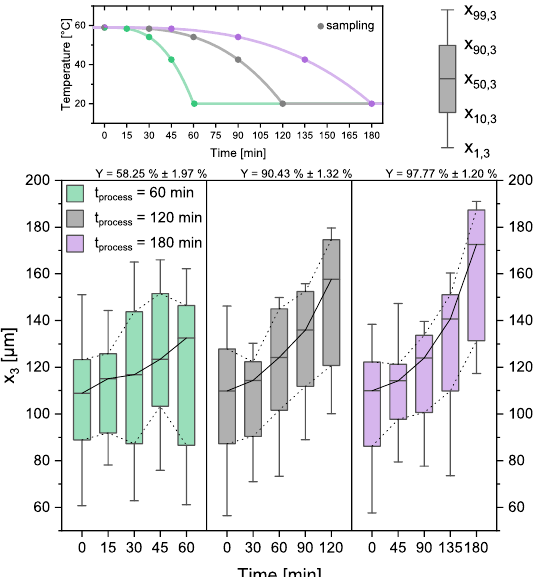
Figure 9. Boxplots of CSDs for three different process times (cooling rates). The temperature profiles and sampling times can be seen in the top panel. Respecting yields are given above the Boxplots. Please note that the time scale for the Boxplots changes. Progressive profile, seed crystal amount